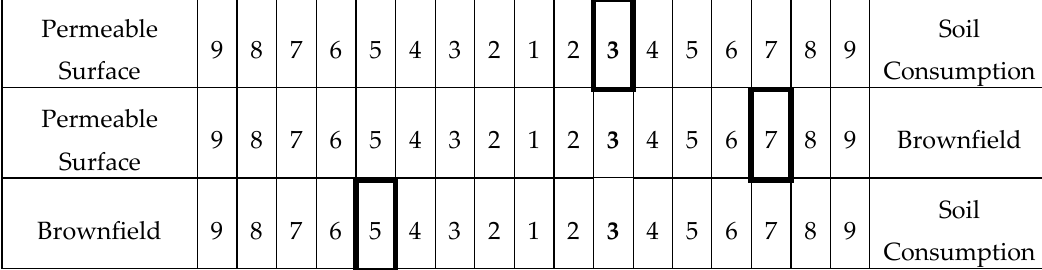
Table 4. Pairwise comparison between Environment nodes.